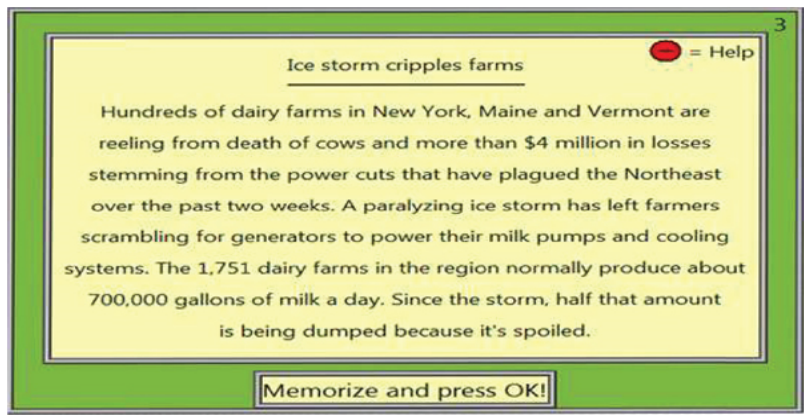
Figure A1. Example of verbal episodic memory. For the training of attention, one target image is presented separately every time at the edge of the screen and is compared to the images in the main frame of the screen. The goal is the identification and the indication of the matching picture to the target picture. (See Figure A2).